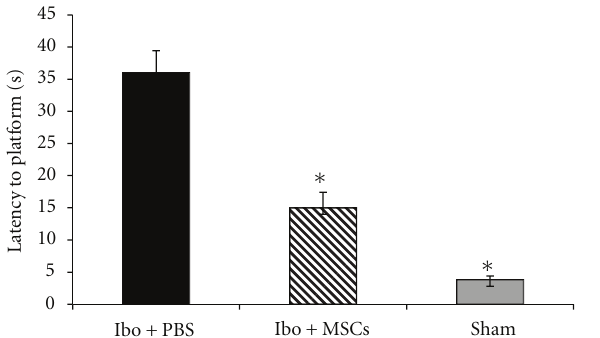
Figure 6: Comparisons of the retention performance on the Morris water maze task among the three groups of the rats. The results are the mean percentage of latency time to the platform in the probe test. The mean values of the four trials for each group are shown. Mean of swimming time among the groups was analyzed using one-way ANOVA and post hoc Tukey’s test. ∗ P < 0 . 05 and ∗∗ P < 0 . 01 as compared with the corresponding data of the Ibo + PBS